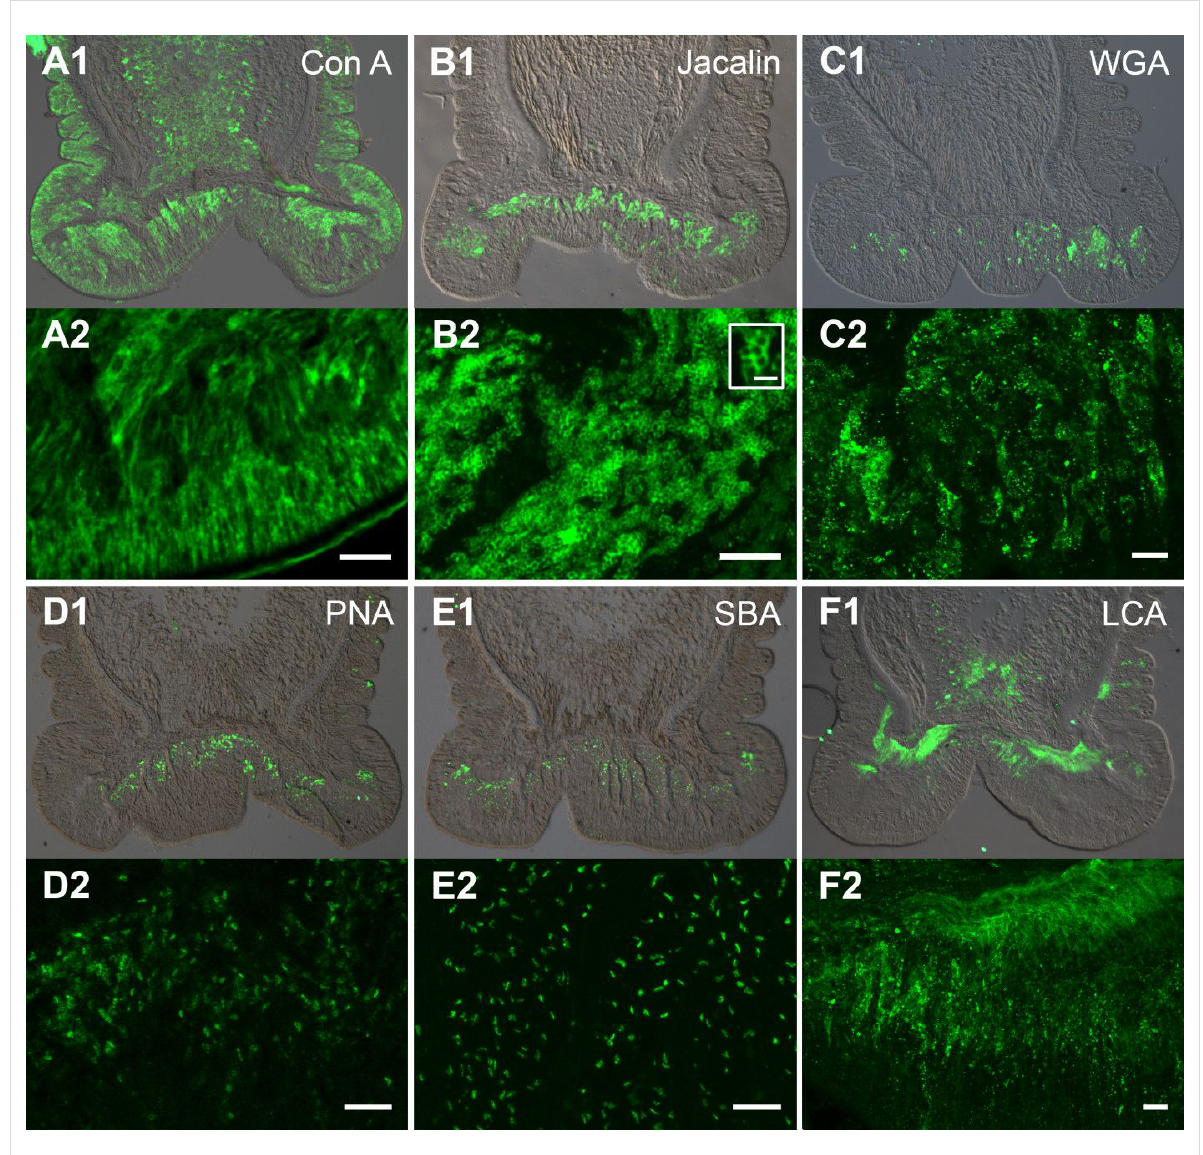
Figure 6: Lectin labelling of tube foot sections in Asterina gibbosa with (A1,A2) Con A, (B1,B2) Jacalin, (C1,C2) WGA, (D1,D2) PNA, (E1,E2) SBA, and (F1,F2) LCA. (A1–F1) Overlay of corresponding fluorescence- and differential interference contrast images. (A2–F2) Confocal z -projections of lectin labelling. Scale bars: 10 µm; (inset) 2